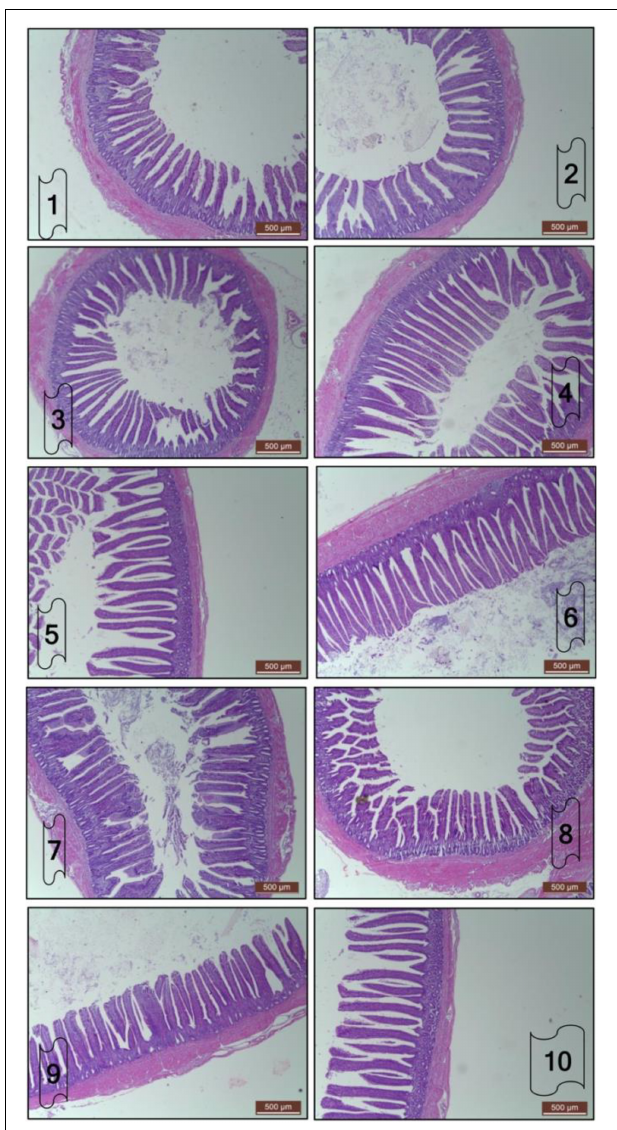
FIGURE 1 | Effect of in ovo inclusion of Bacillus subtilis , raffinose, and their synbiotics on ileal histomorphometry of 21-day-old broilers. Each number on the figure means the following groups: 1 = non-injected group; 2 = sterile distilled water; 3 = Bacillus subtilis 4 × 10 5 /egg; 4 = Bacillus subtilis 4 × 10 6 /egg; 5 = Raffinose 2 mg/egg; 6 = Raffinose 3 mg/egg; 7 = ( Bacillus subtilis 4 × 10 5 + Raffinose 2 mg)/egg; 8 = ( Bacillus subtilis 4 × 10 5 + Raffinose 3 mg)/egg; 9 = ( Bacillus subtilis 4 × 10 6 + Raffinose 2 mg)/egg; 10 = ( Bacillus subtilis 4 × 10 6 + Raffinose 3 mg)/egg. Images were captured with light microscopy. Scale bar indicates 500 µ m.